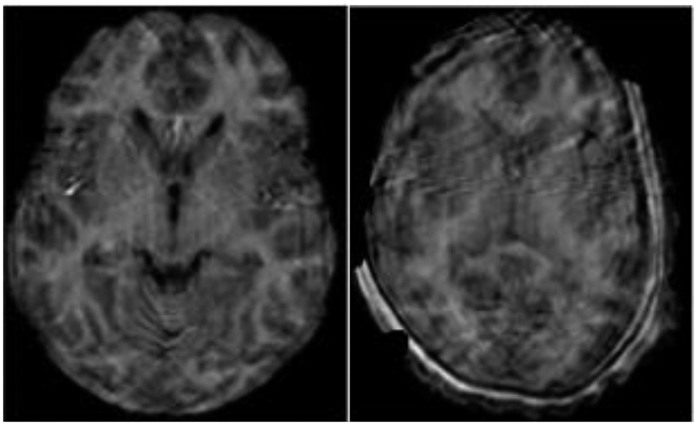
Examples of excluded data.